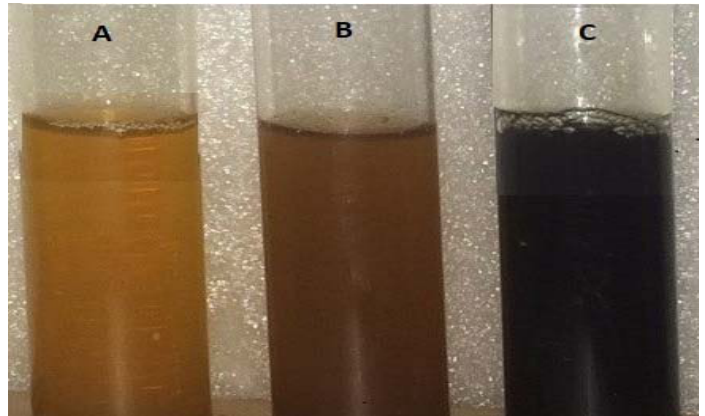
Figure 1. Color changes and density of precipitate formed immediately after mixing of iron salt to grape seeds extract. ( A ) 5 min, ( B ) 1 h, ( C ) 36 h. grape seeds extract. ( A ) 5 min, ( B ) 1 h, ( C ) 36 h.